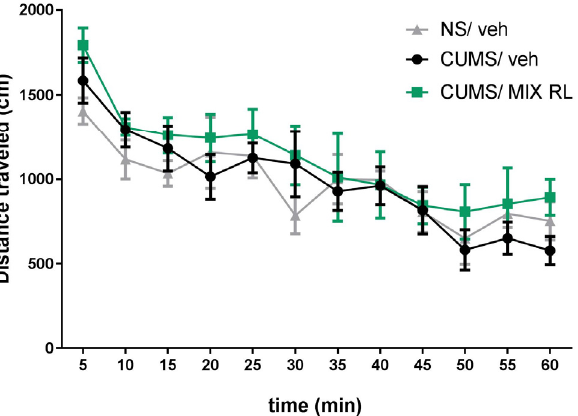
Figure 3. Effect of (R)-ketamine (1 mg/kg) co-administered with LY341495 (0.3 mg/kg) (mixRL) on the locomotor activity of mice. The values are expressed as the means ± SEM and were analyzed by repeated-measures ANOVA (N = 6).